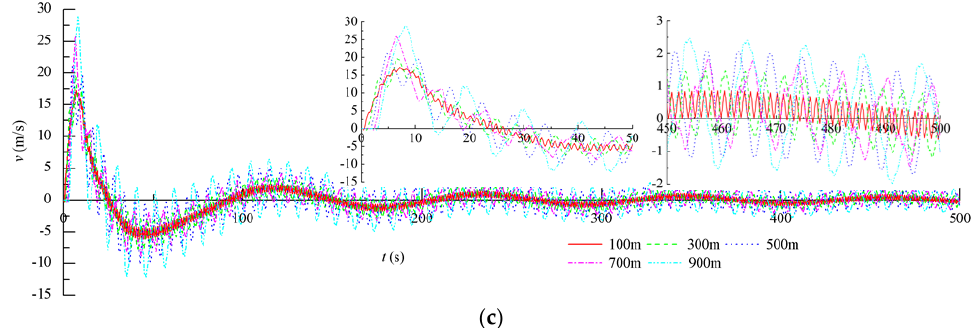
Figure 11. Effect of the length of ventilation tunnel on wind speed; ( a ) Positive and negative (extrema)